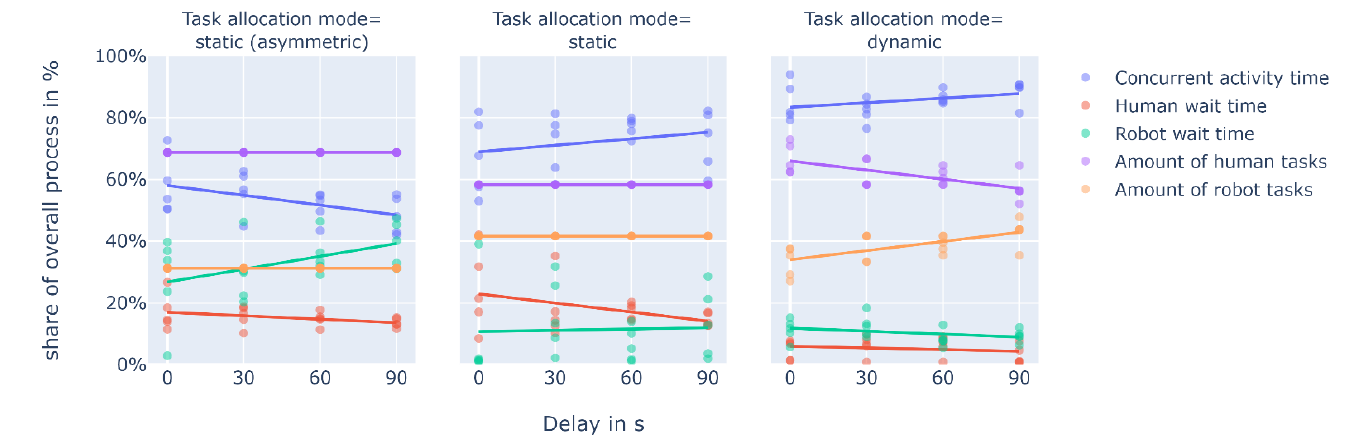
Figure 20. HRC performance KPI for the different task allocation modes depending on the duration of delay for the assembly of three components.